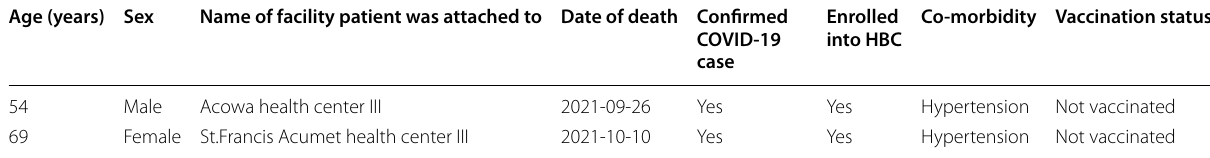
Table 4 Description of COVID‑19 patients managed under home‑based care who died in Kapelebyong district in eastern Uganda Age (years)